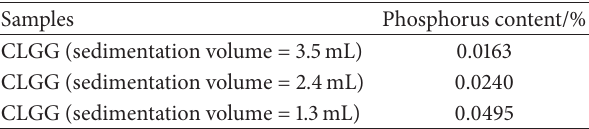
Table 5: Effect of cross-linking and oxidation on freeze-thaw stability and swelling power of GG.